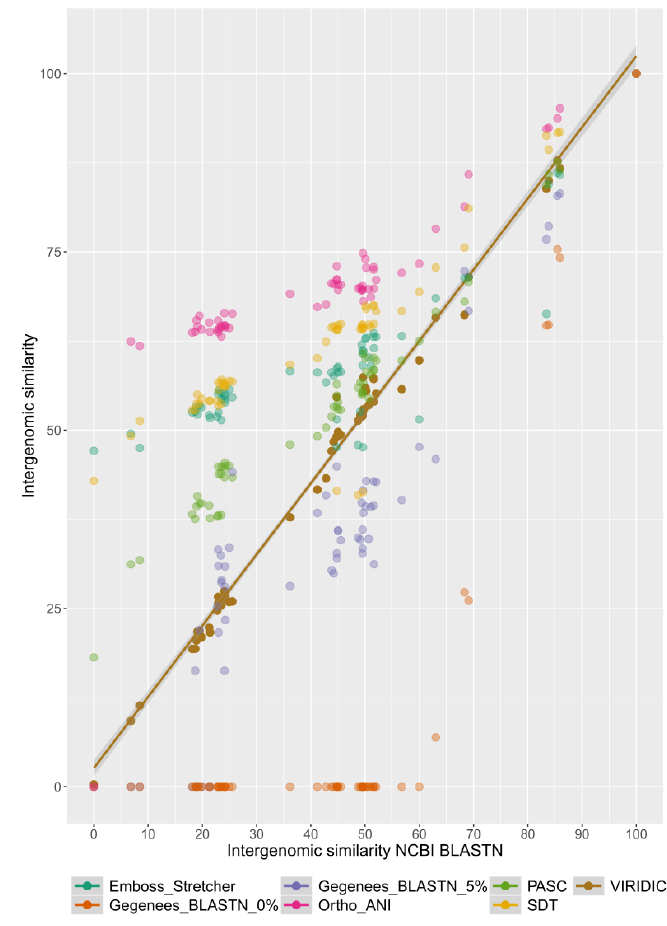
Figure 2. Plot comparing intergenomic similarity values generated by different tools (on the Y axis) with those generated by the traditional method used by ICTV (on the X axis). The plot was generated with the ggplot2 R package [22]. Data used for this plot are found in Table S1.